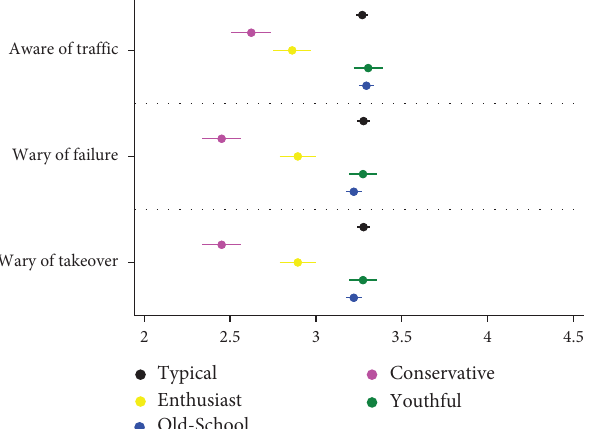
Figure 9: Mean values of attitudinal variables with 95% confdence interval by consumer classes. Measured items on the vertical axis: I think I would be more aware of the trafc environment in a CAC than when I would drive on my own; I would be concerned that a failure or malfunction of a CAC may cause accidents; I would be concerned to take over control of a CAC after being engaged in activities other than driving (e.g., watching a movie, using social media).